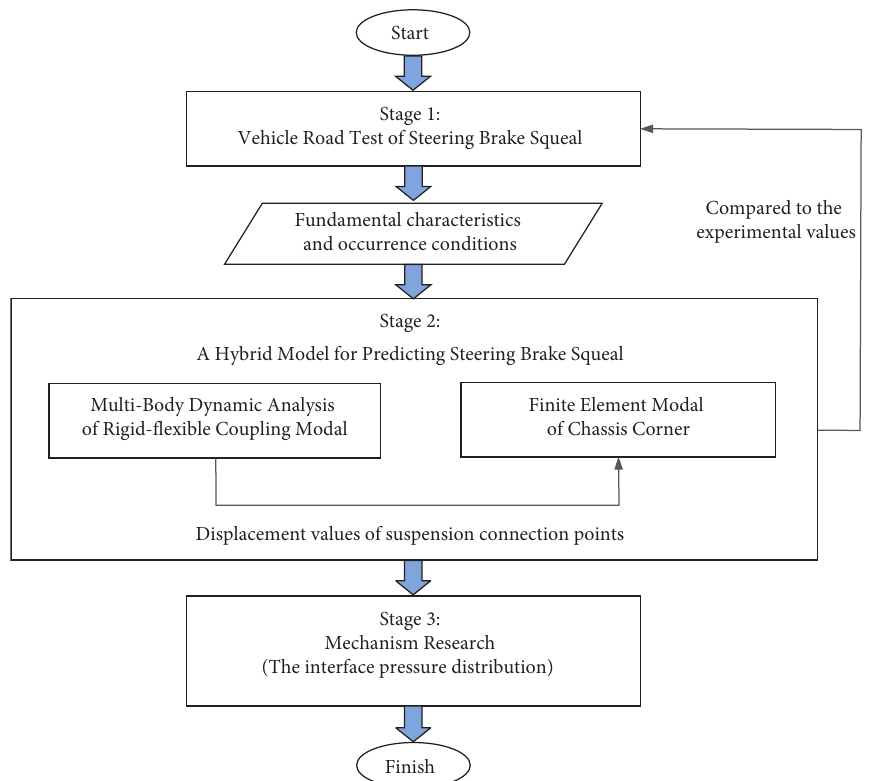
Figure 2: Three stages in the analysis of steering brake squeal propensity.